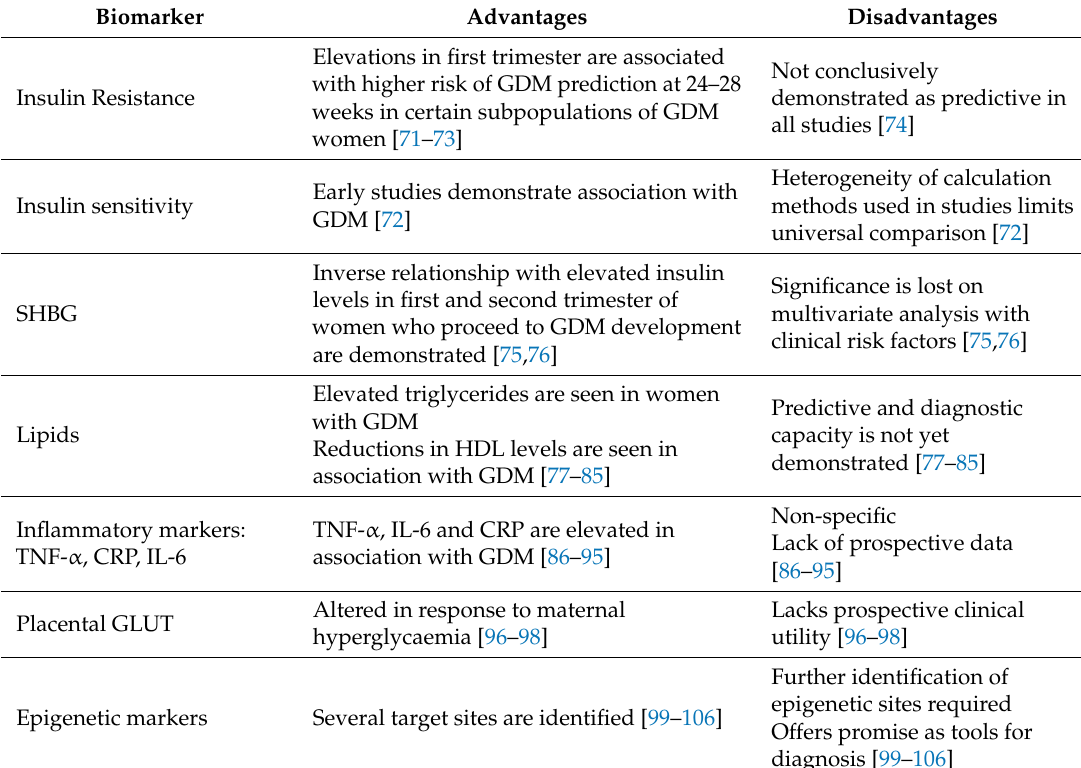
Table 2. Biomarkers under investigation in